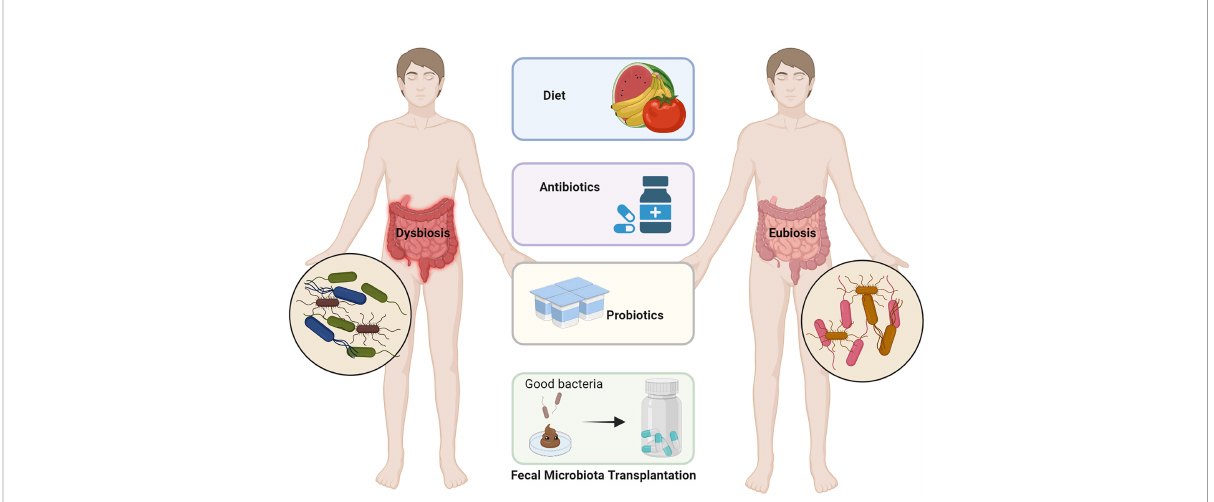
FIGURE 3 Various approaches for modi fi cation of the dysbiotic gut. Dietary modi fi cations such as increasing dietary fi ber, antibiotic treatment for pathogenic bacteria, probiotics to increase the colonization of bene fi cial bacteria in the gut, and fecal microbiome transplantation (FMT) are all options for regulating intestinal fl ora imbalance (adapted from 16). (The fi gure was created with